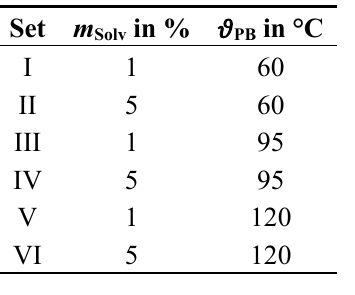
Table 1. Sets of process parameters for experiments on material properties of SU-8 with hardbake temperature of 240 °C for all sets.